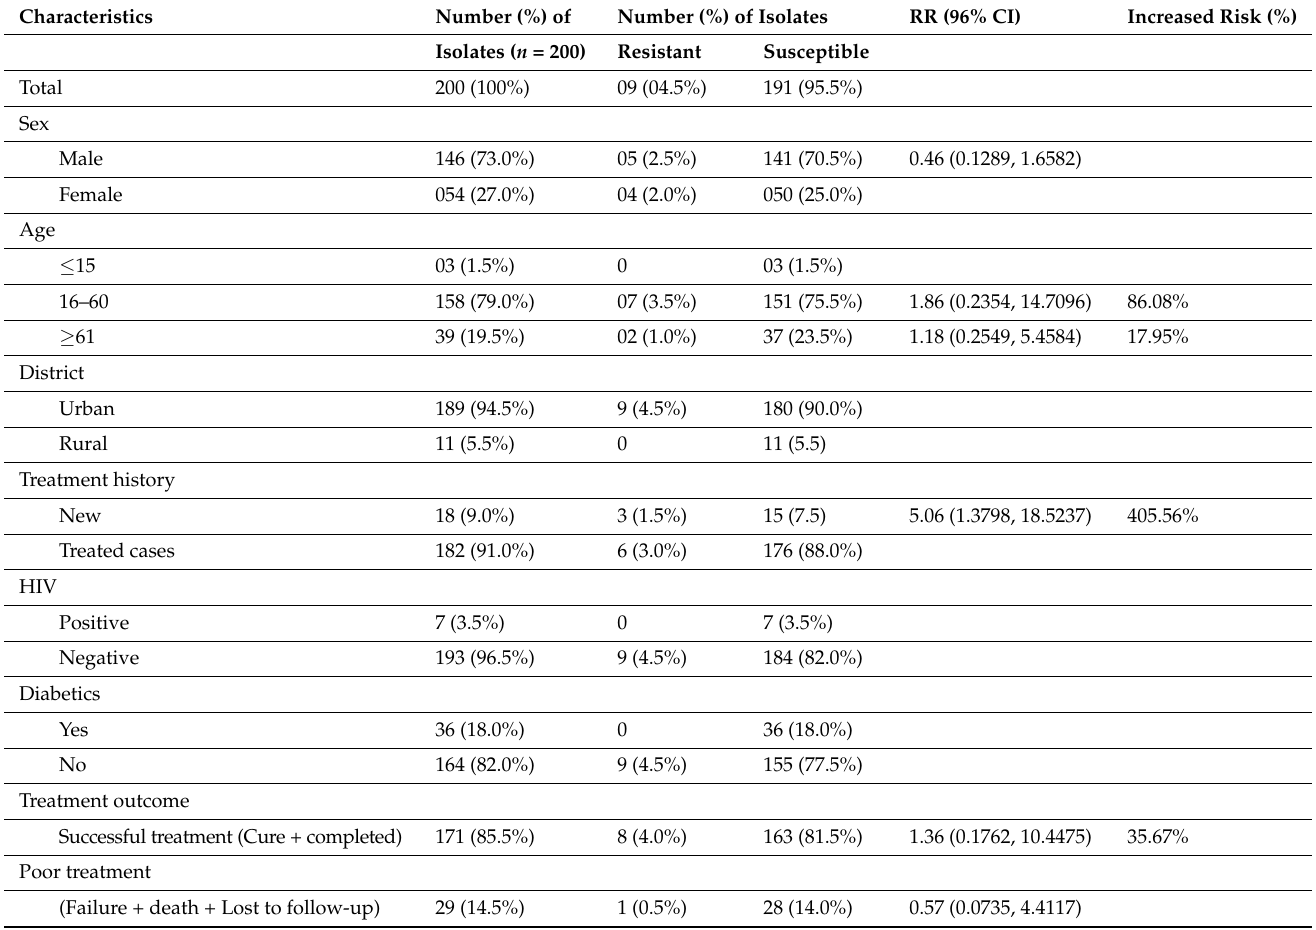
Table 4. Multivariate analysis to evaluate the risk factors of pre-XDR among 200 isoniazid mono- resistant